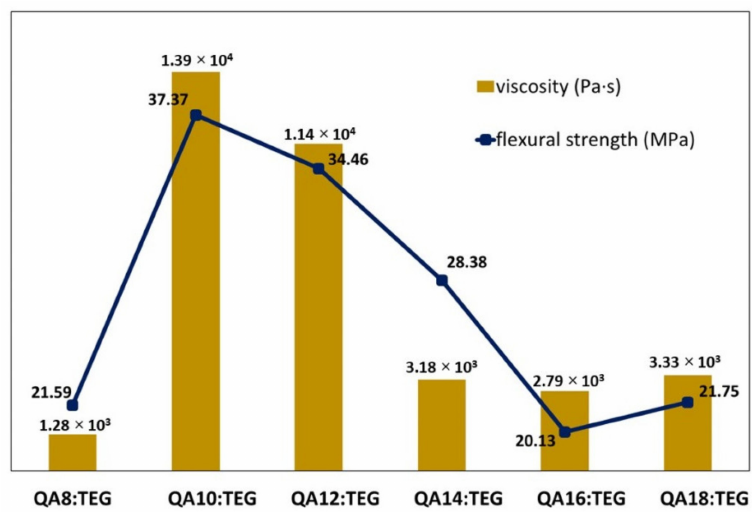
Figure 4. Flexural strength of the QA:TEG copolymers and viscosity of the QAUDMA monomers.